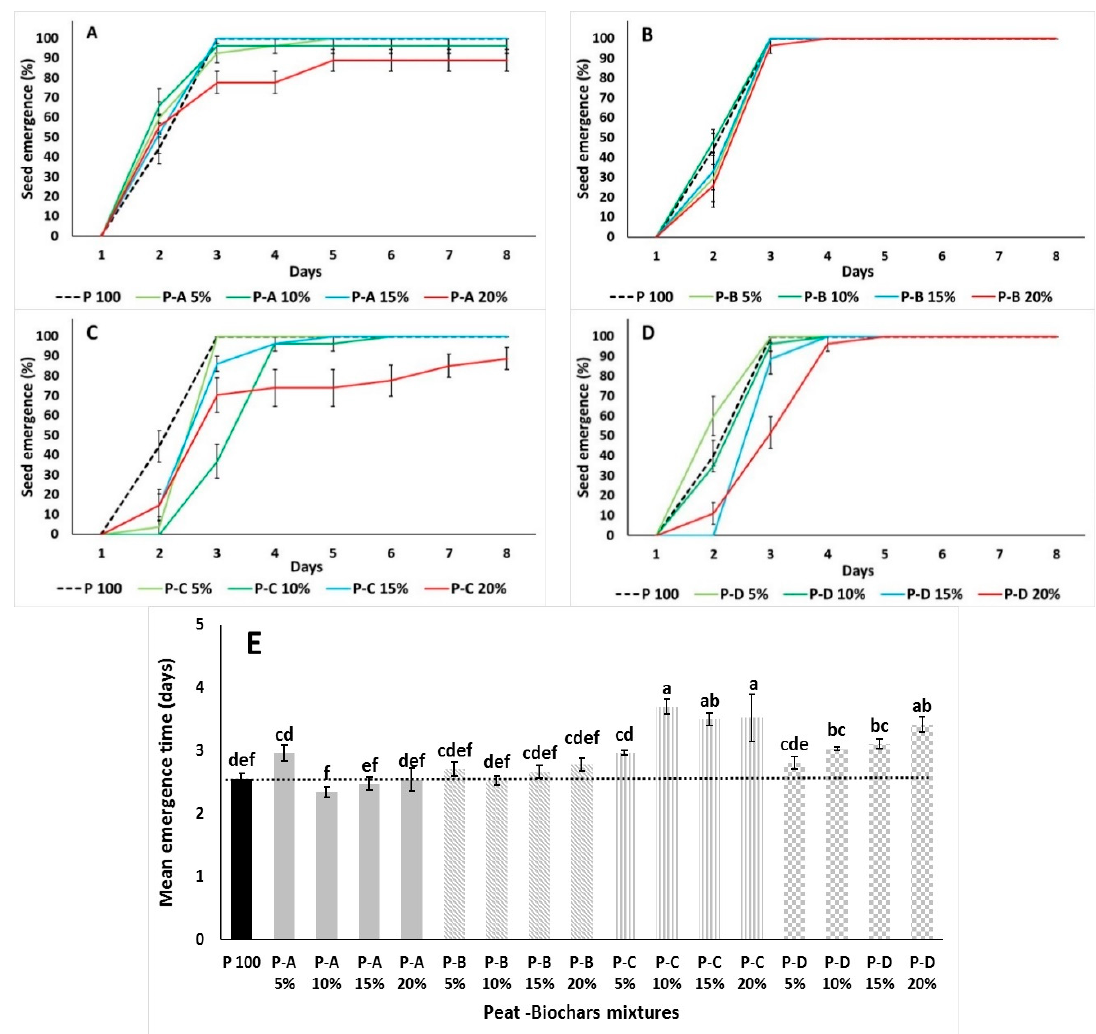
Figure 1. Cabbage cumulative seedling emergence and mean emergence time (MET) in peat with different biochar types (A, B, C, D) and ratio (0-5-10-15-20%). Biochar type is distinguished by different pattern at MET. Significant differences ( p < 0.05) among treatments are indicated by different letters. Error bars show SE ( n = 4). Dotted line present the levels of control treatment (100% peat). ( A ) is referring to Biochar A, ( B ) is Biochar B, ( C ) is Biochar C, ( D ) is Biochar D, ( E ) is mean emergence time for all biochars.